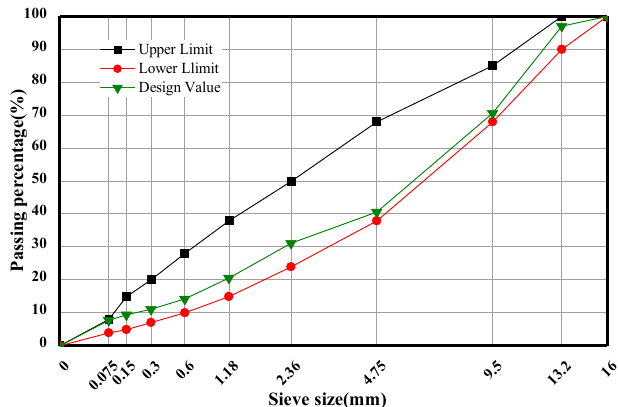
Figure 1. Gradation of aggregate for asphalt mixture AC-13.